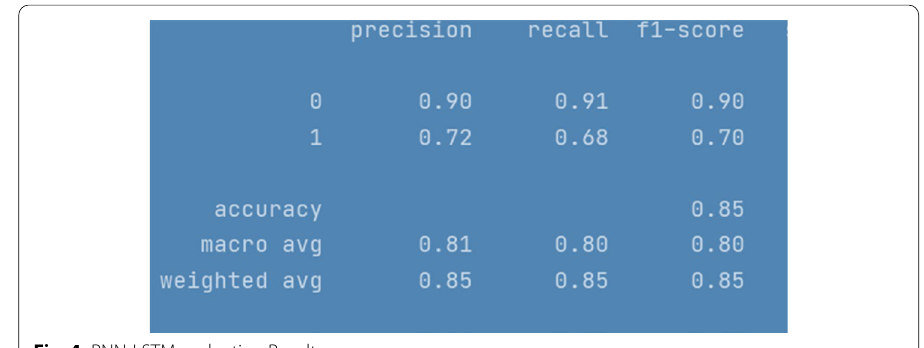
Fig. 4 RNN-LSTM evaluation Results